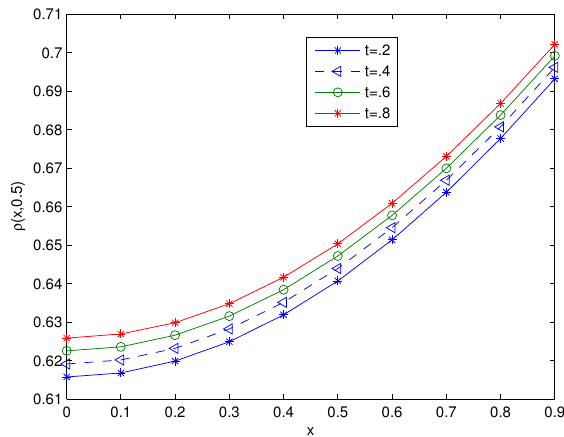
Figure 5. Numerical solution at different times t for ρ ( x ,0.5 ) , corresponding to Example 2.